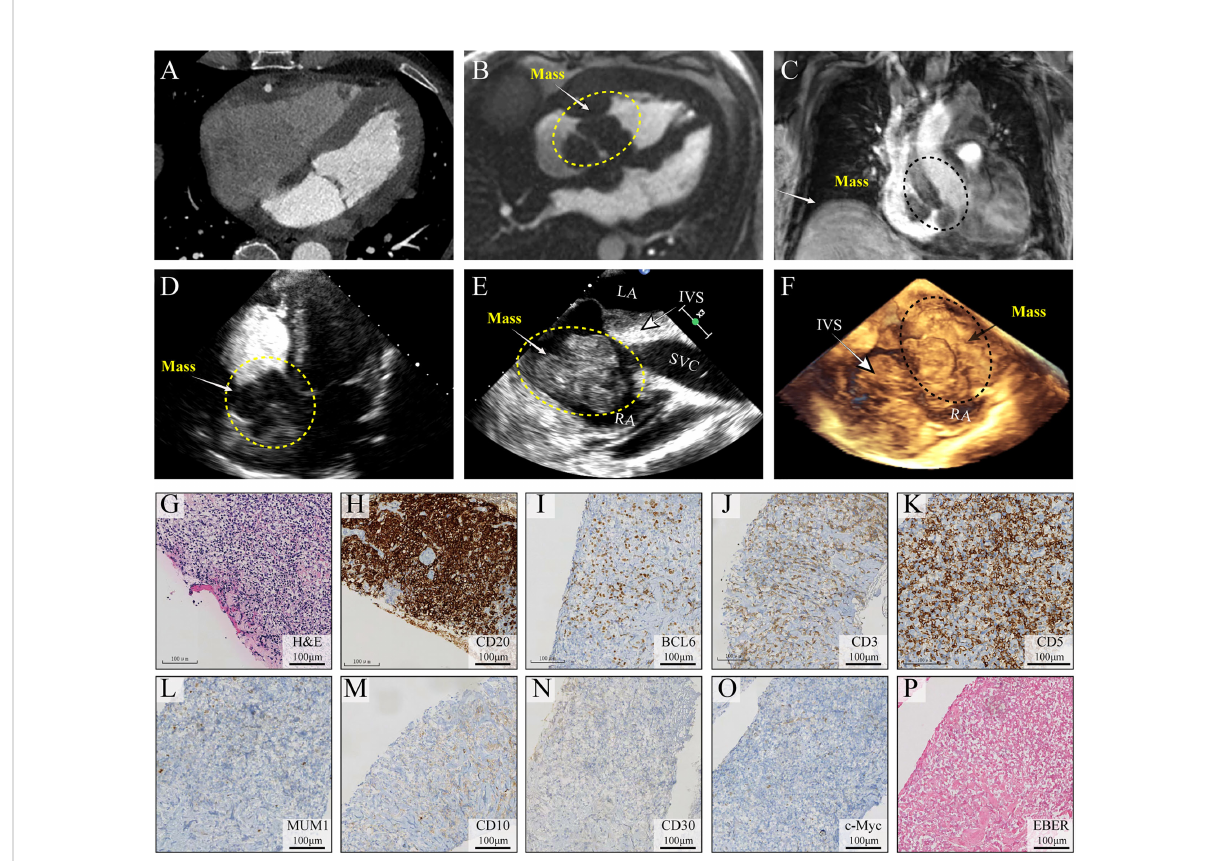
FIGURE 2 Multimodality medical imaging diagnosis and histopathological examination of the mass. (A) Computed tomography obtained 2 months before showed no mass in the right heart. (B, C) Cine MRI demonstrated a large in fi ltrating mass extending in the right atrium and ventricle, occupying most of the right atrium. (D – F) Left ventricular opaci fi cation, TEE, and 3D ultrasonic imaging of the morphological feature of the mass. (G – O) Histological examination of the lymph node, H&E, CD20, BCL6, CD3, CD5, MUM1, CD10, CD30, and c-Myc, (P) EBV infection was identi fi ed using in situ hybridization (ISH) for the detection of EBV-encoded small RNA (EBER) EBER staining. IVS, interventricular septum; TEE, transesophageal echocardiography; EBV, Epstein – Barr